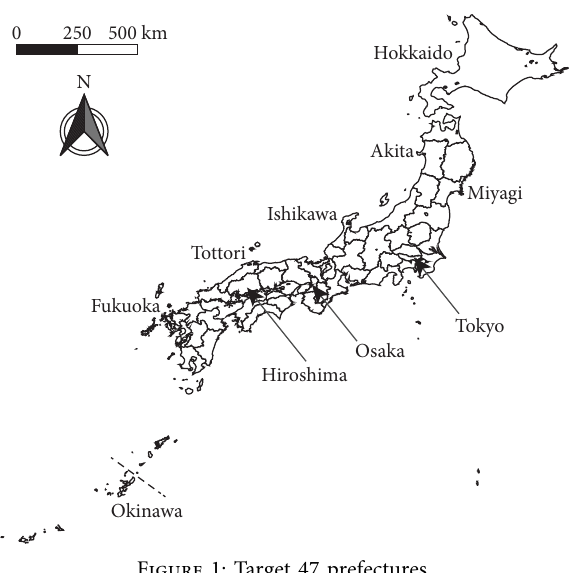
Figure 1: Target 47